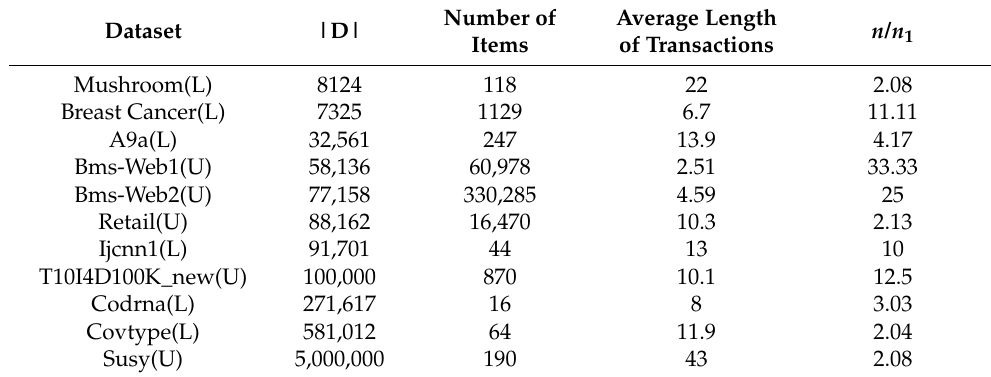
Table 8. Experimental dataset.